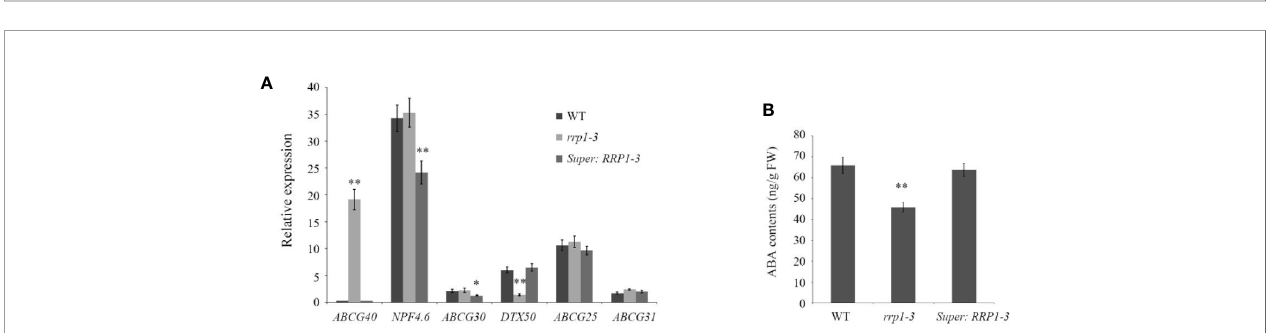
FIGURE 7 | Interaction of RRP1 with PYR1 in Arabidopsis . (A) BiFC assay showing interaction of RRP1 and PYR1. eYFP, enhanced yellow fl uorescent protein. YFP N and YFP C are the N terminus and C terminus of eYFP, respectively. Scale bars, 20 m m. (B) Co-IP assay of RRP1 with PYR1. Super : PYR1-GFP and 35S:Flag- HA-RRP1 , or Super : GFP and 35S:Flag-HA-RRP1 were co-transfected into Arabidopsis protoplasts. Co-IP was conducted with anti-Flag beads from total isolated proteins, and immunoblotting analysis was performed with anti-GFP and anti-Flag antibodies. (C) The N-terminus of RRP1 primarily interacts with PYR1. Yeast transformants were spotted onto the selective medium SD/ − Leu/ − Trp/ − His/ − Ade ( − LTHA)/+X- a -gal supplemented with 0 or 40 m M